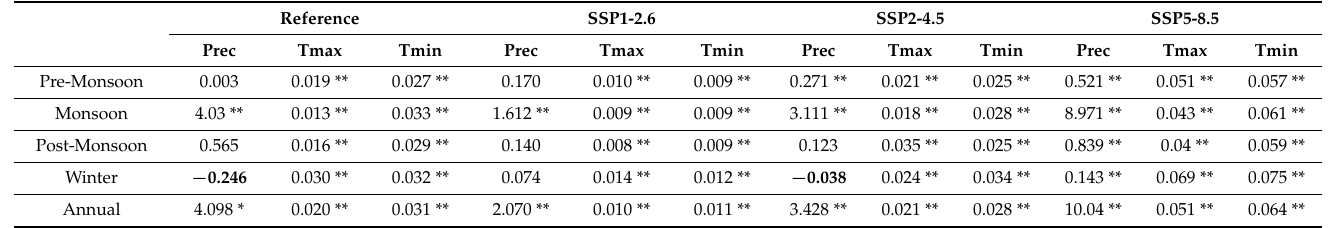
Table 3. The seasonal and annual precipitation and temperature trend for reference and projected periods under three different SSP scenarios (unit = mm/year; ◦